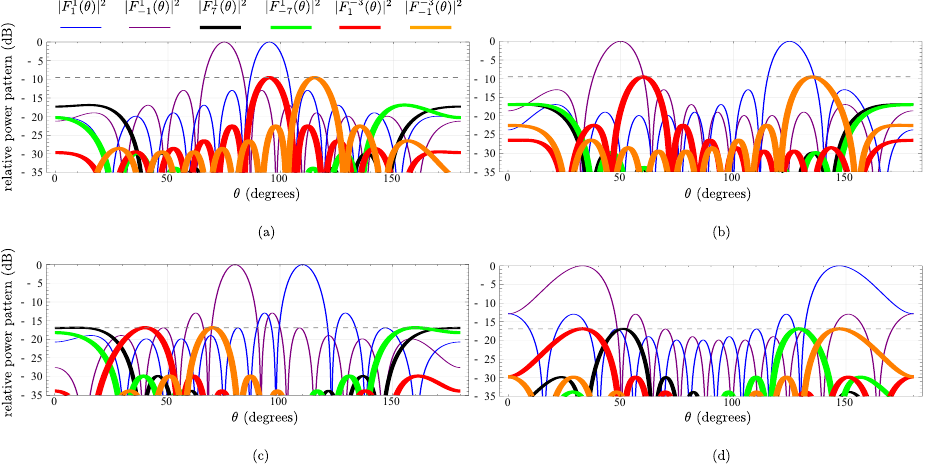
Figure 7. Relative power patterns (dB) for N = 10. ( a ) Dual-beam steerable TMA approach in Figure 6, i.e., considering 4-level AM and 4-level PM waveforms where the two useful beam patterns are pointing towards the directions 75 ◦ and 95 ◦ , respectively. ( b ) The same TMA approach as in ( a ), but the pointing directions are 50 ◦ and 125 ◦ . ( c ) Dual-beam steerable TMA approach considering 4-level AM and 8-level PM waveforms where the two useful beam patterns are pointing towards the direction of 80 ◦ and 110 ◦ . ( d ) The same TMA approach as in ( c ), but considering a scenario where the two useful beam patterns point towards 33 ◦ and 147 ◦ (i.e., ± 57 ◦ from the broadside direction) which correspond to the limits of the scanning interval that each useful beam pattern is able to